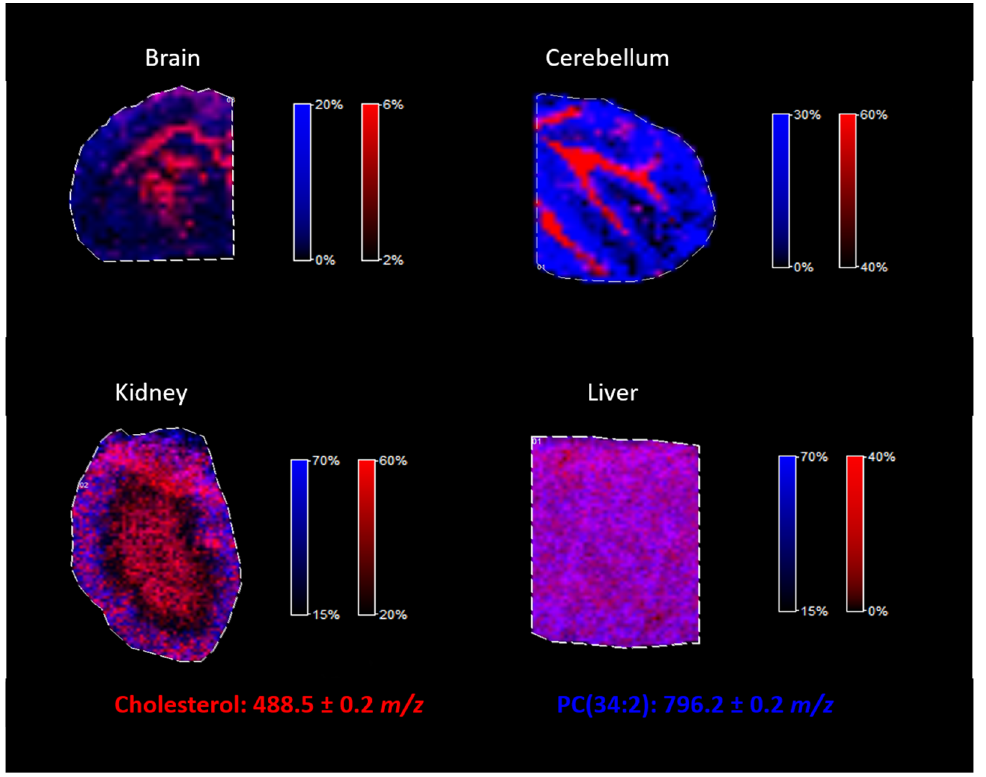
Figure 8. Cholesterol analysis in the different tissues after derivatization by betaine aldehyde with an optimized derivatization approach.